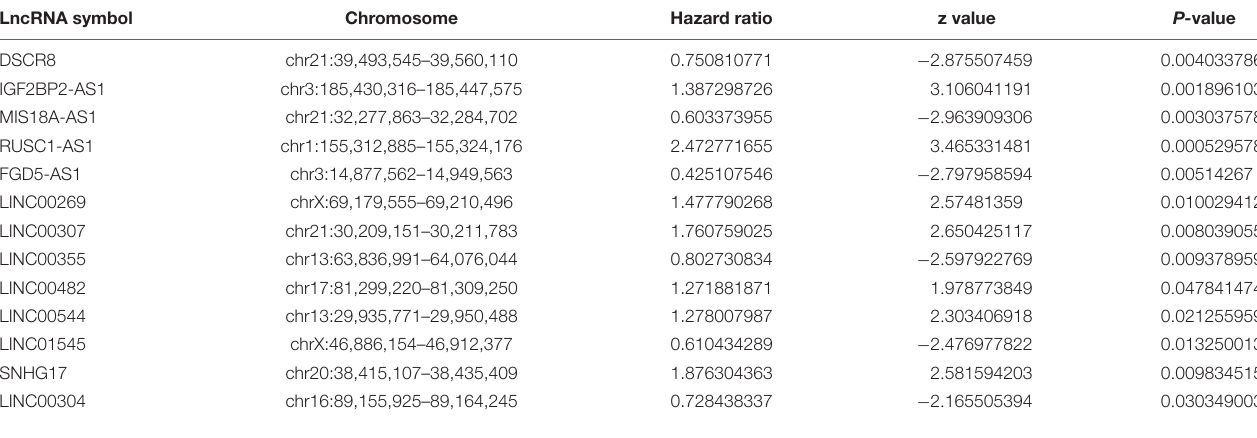
TABLE 2 | 13 autophagy-related lncRNAs identified as prognostic factors in osteosarcoma. LncRNA